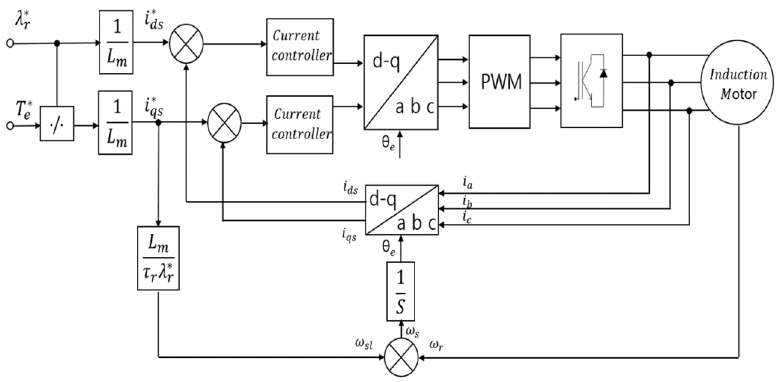
Figure 11. Schematic diagram of the FOC control method for a propulsion motor in the